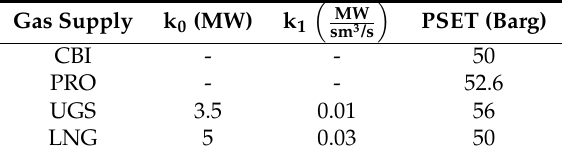
Table 4. Input data for facilities supplying the gas system with gas.